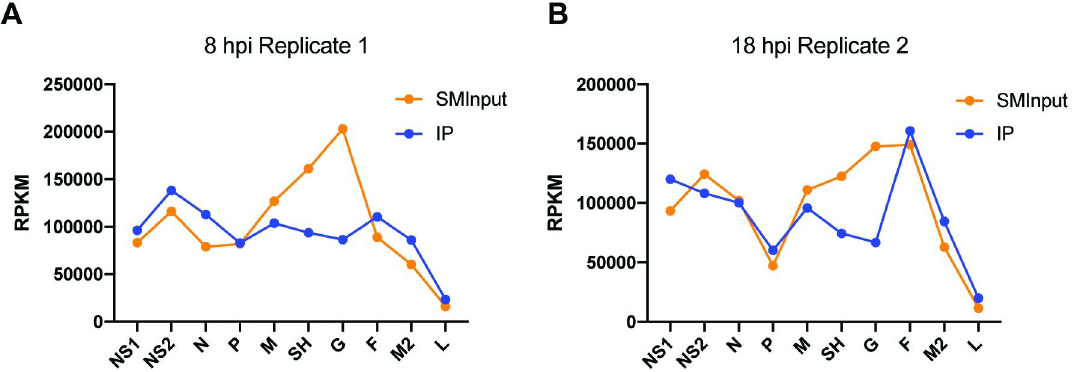
Fig 7. M2-1: RNA interactions show evidence of a transcription gradient. RPKM values were calculated for RSV positive sense sequences represented in the SMInput and IP datasets and plotted against each of the RSV genes. The figure shows graphs for the 8 hpi replicate 1 (A) and 18 hpi replicate 2 samples (B); graphs for the other samples are presented in S3